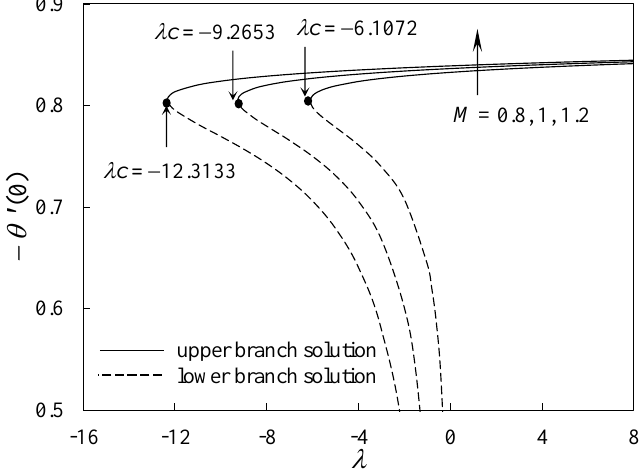
Figure 18. Variation of − θ (cid:48) ( 0 ) with λ for several values of M for Cu-water